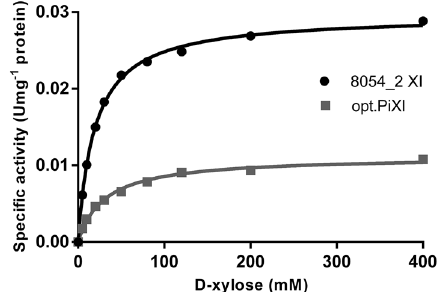
Figure 5. Enzymatic specific activity of the XI enzymes 8054_2 XI or the codon-optimized XI from Piromyces sp. E2 (opt.PiXI). Kinetic parameters were determined from a Michaelis–Menten plot adjusted to the experimental data (R squared > 0.99). Strains were grown in synthetic medium containing 2% (w/v) d-xylose until the exponential growth phase. Crude cell extracts were prepared and used immediately in the activity assays. Data points represent an average of 3 biological replicates.